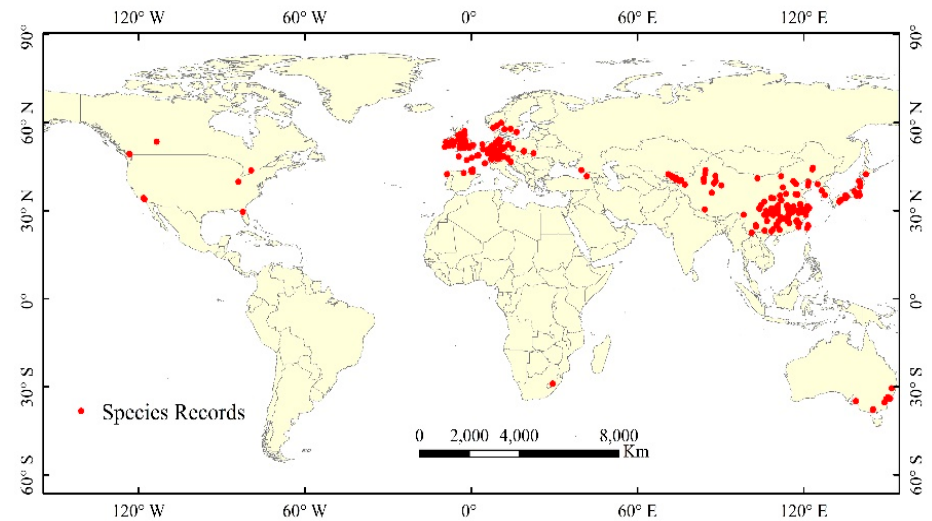
Figure 1. The global sampling points of M. glyptostroboides .